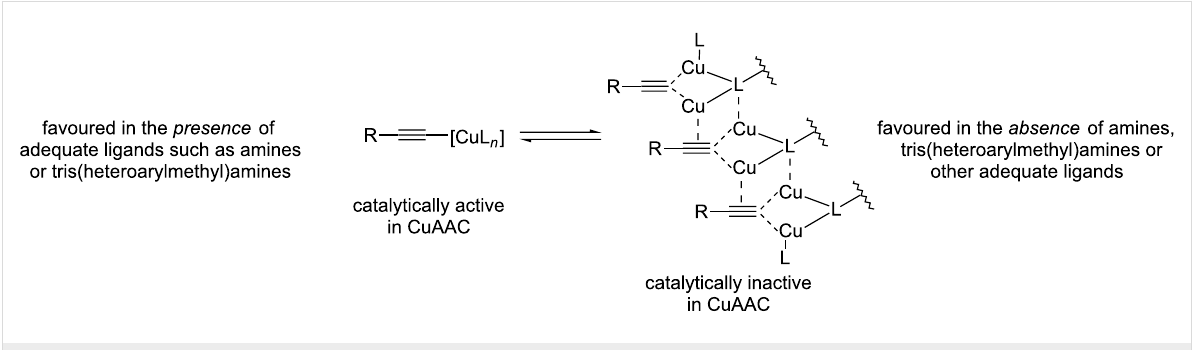
Scheme 19: Off-cycle equilibrium between unreactive polymeric copper(I) acetylide species (right) and reactive monomeric copper(I) acetylides (left) as proposed by Fokin [42,63].